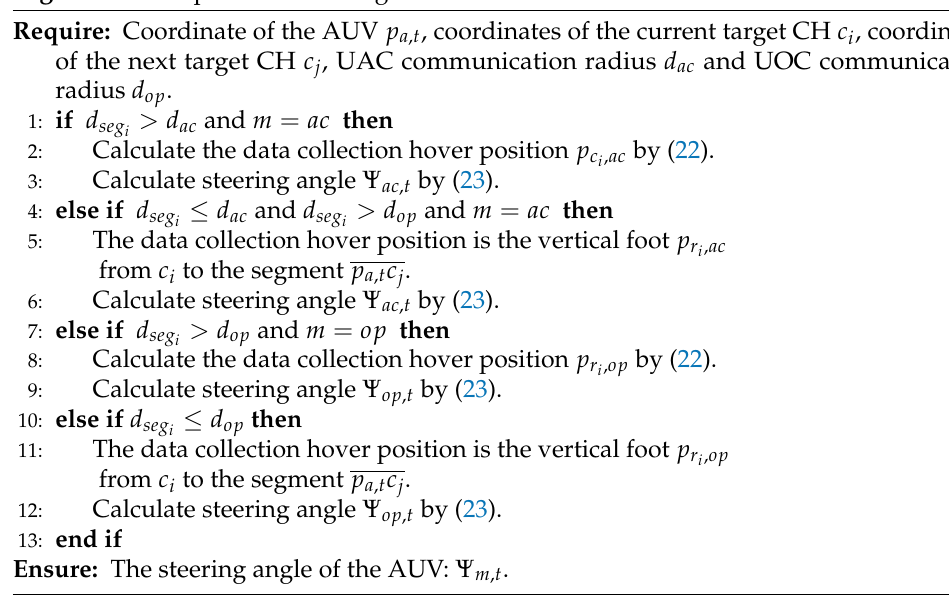
Algorithm 1 Proposed MSAO